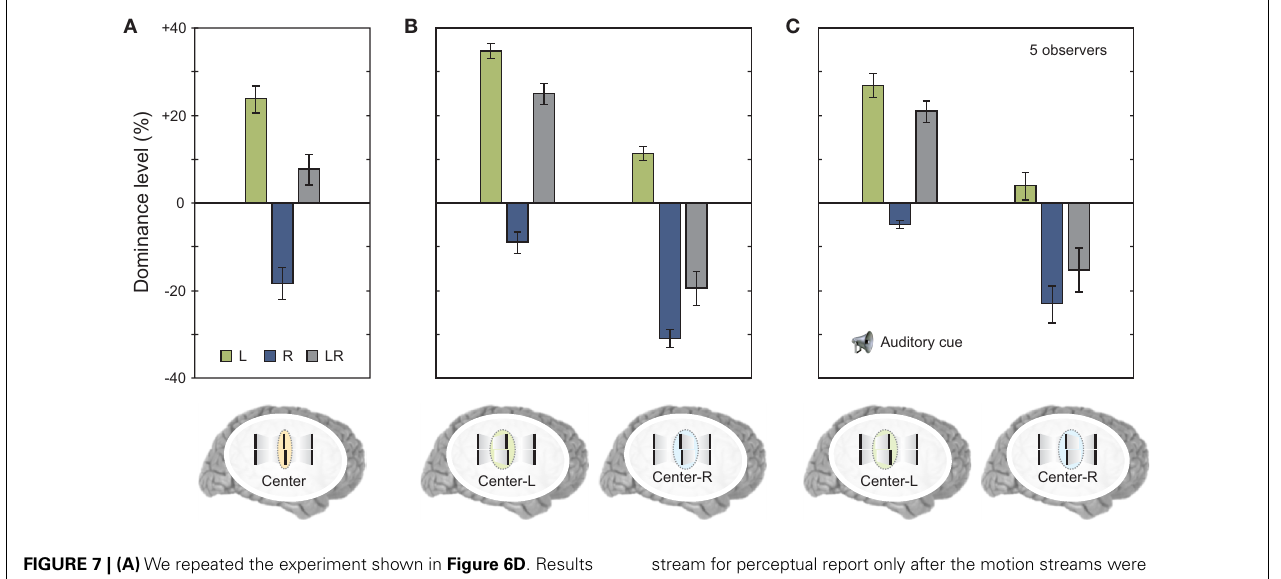
FIGURE 7 | (A) We repeated the experiment shown in Figure 6D . Results were virtually identical. (B) Next we asked observers to attend selectively to the stream coming from the left or from the right to the center. Offsets were not combined similar to experiments shown in Figure 6F . (C) We repeated the experiment but presented a post-cue that indicated the